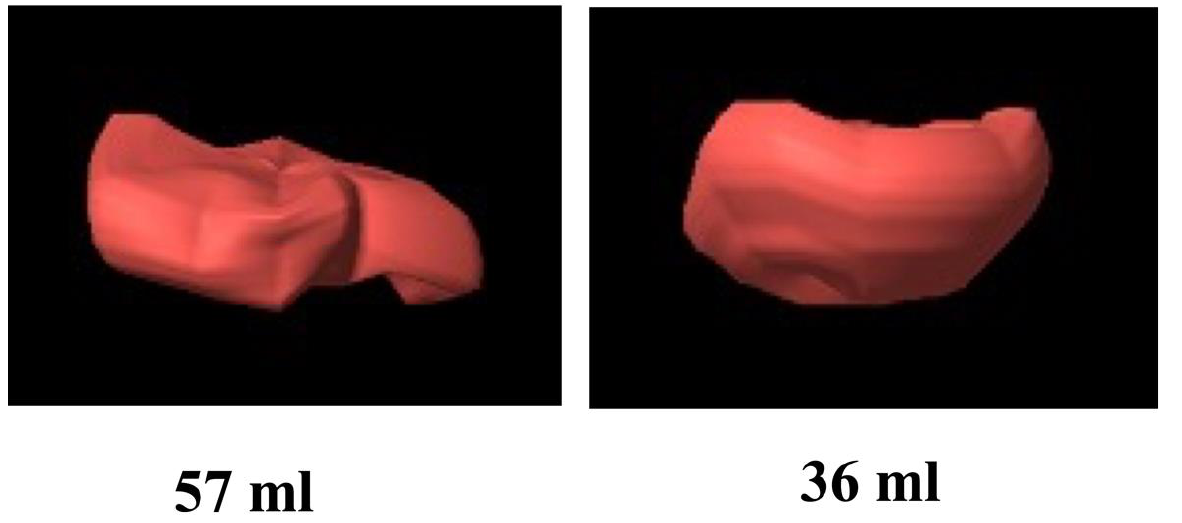
Figure 2. Example of 3D reconstruction of the placental volume at 12 weeks in a spontaneously conceived pregnancy and in an IVF with fresh embryo. The volume is significantly reduced in the latter.